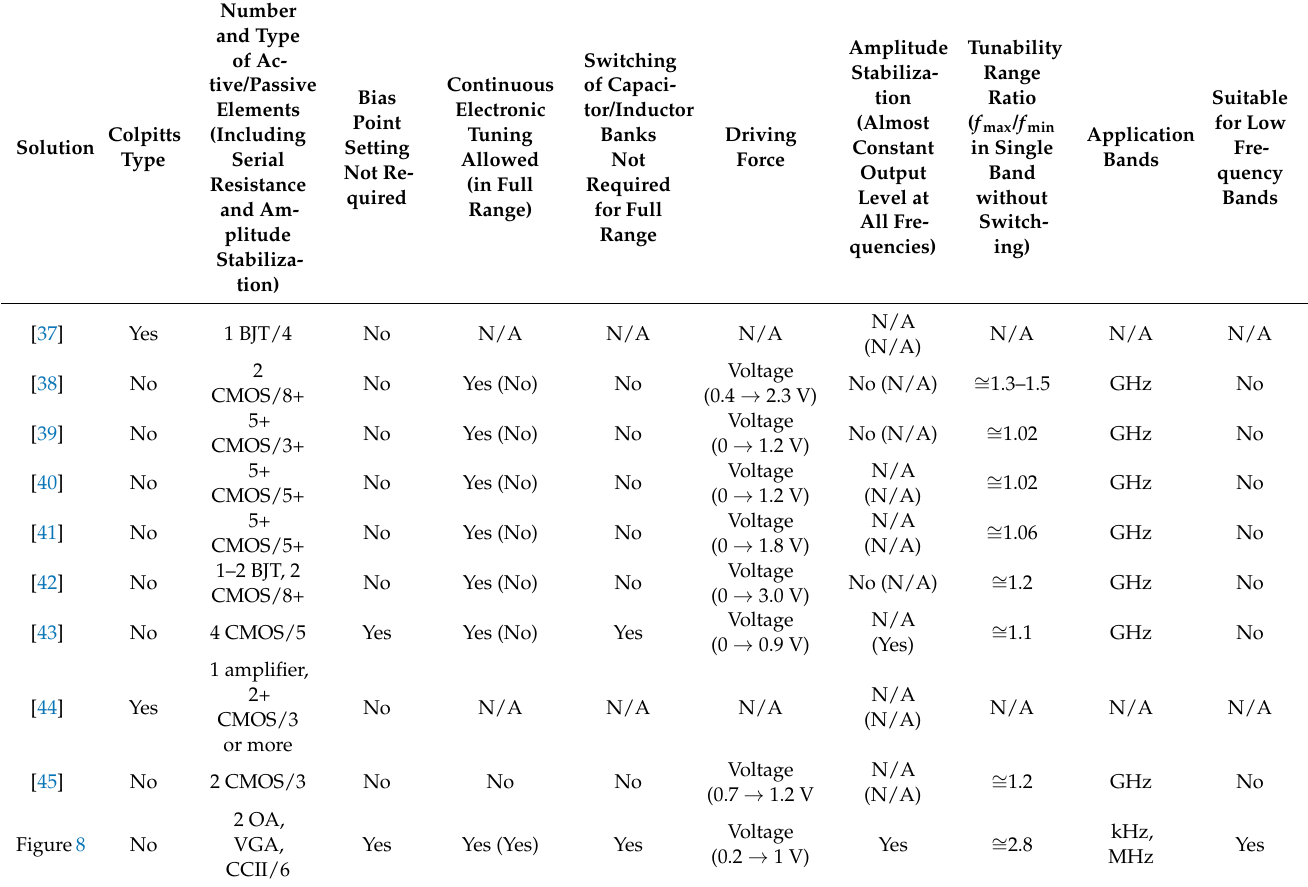
Table 2. Brief comparison of typical LC oscillators and proposed